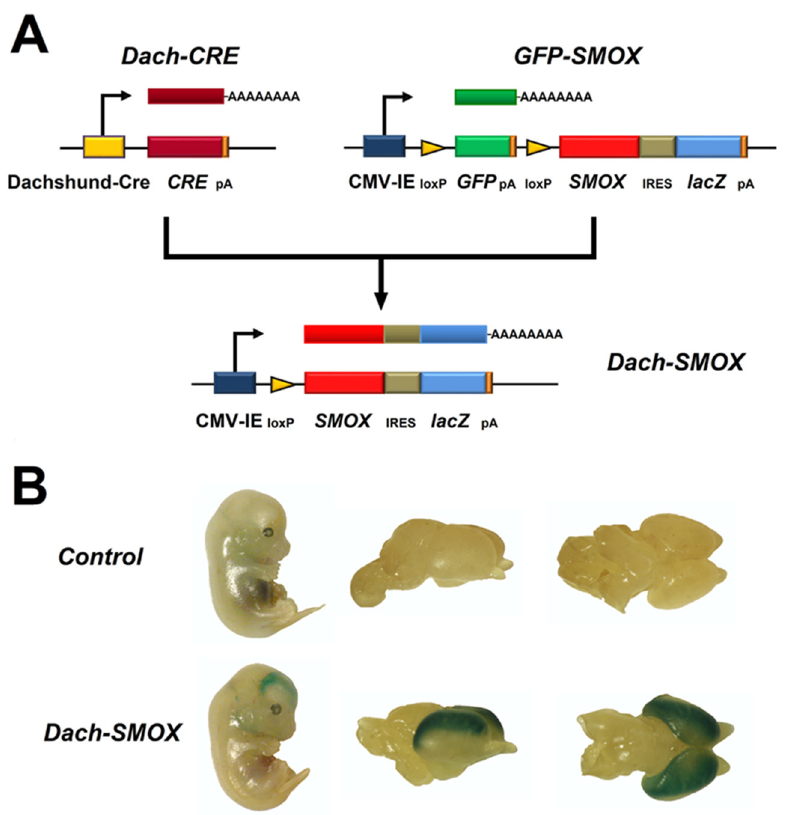
Figure 4. Scheme of Dach-SMOX mouse generation. ( A ) CRE recombination scheme between Dach- CRE and GFP-SMOX to obtain Dach-SMOX mouse lines. ( B ) Left-side, LacZ staining of wholemount at E12.5 mouse developmental stage of Dach-SMOX and control embryos; right-side, LacZ staining of brains at E14.5 mouse developmental stage of Dach-SMOX and control